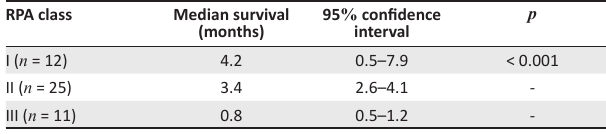
TABLE 4: Survival by Recursive Partitioning Analysis